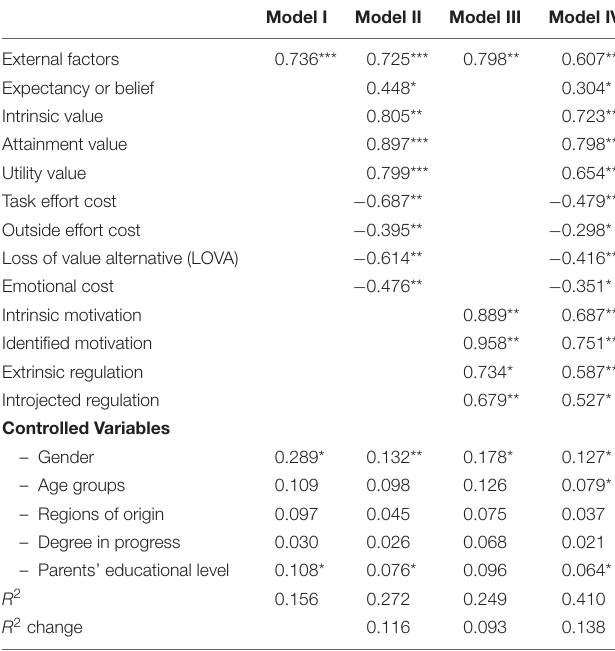
TABLE 3 | Unstandardized β -coefficients from hierarchical multiple regression (HMR)